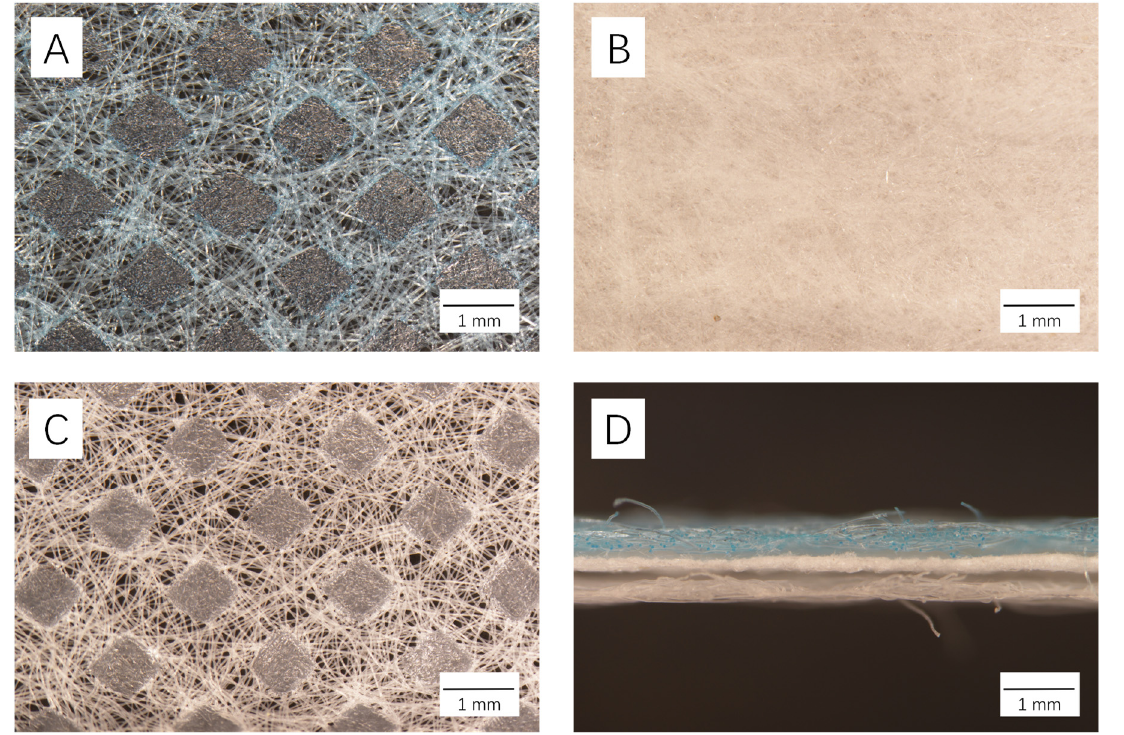
Figure 1 . Representative images of the outer layer ( A ), inner layer ( B ), middle layer ( C ), and a cross section of all three layers ( D ) of a disposable mask under a light microscope.